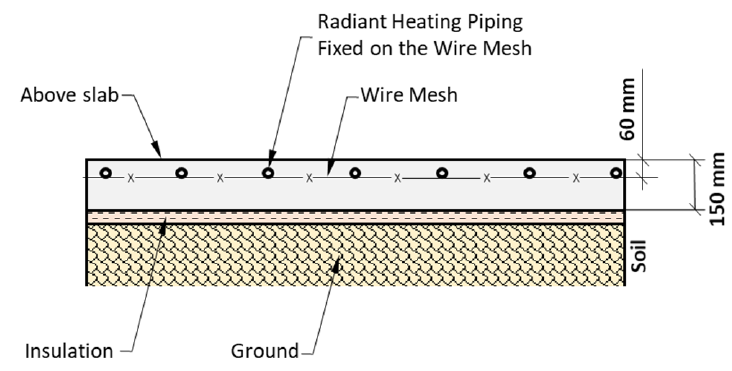
Figure 12. Slab cut with hydronic radiant heating piping.